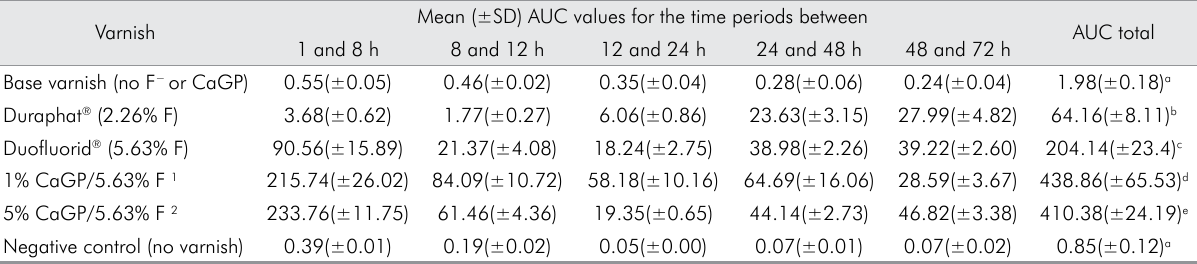
Table 1. Mean cumulative ±SD values for the area under the curve (AUC) for fluoride release from each group. Mean (±SD) AUC values for the time periods between Varnish